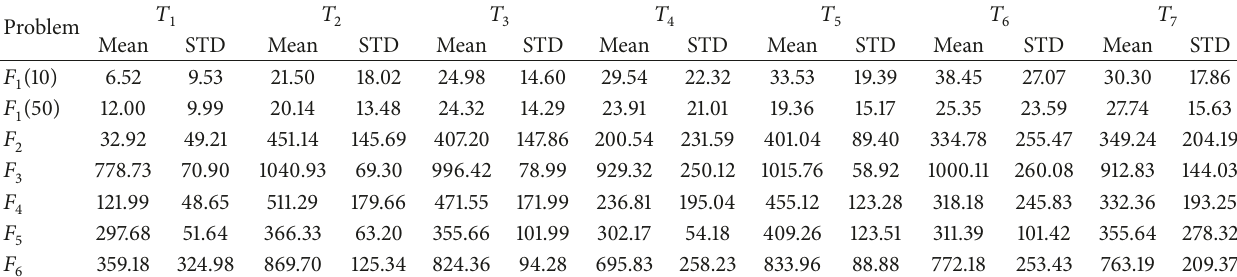
Table 9: Mean error values achieved for problems 𝐹 1 – 𝐹 6 by Basic BA.